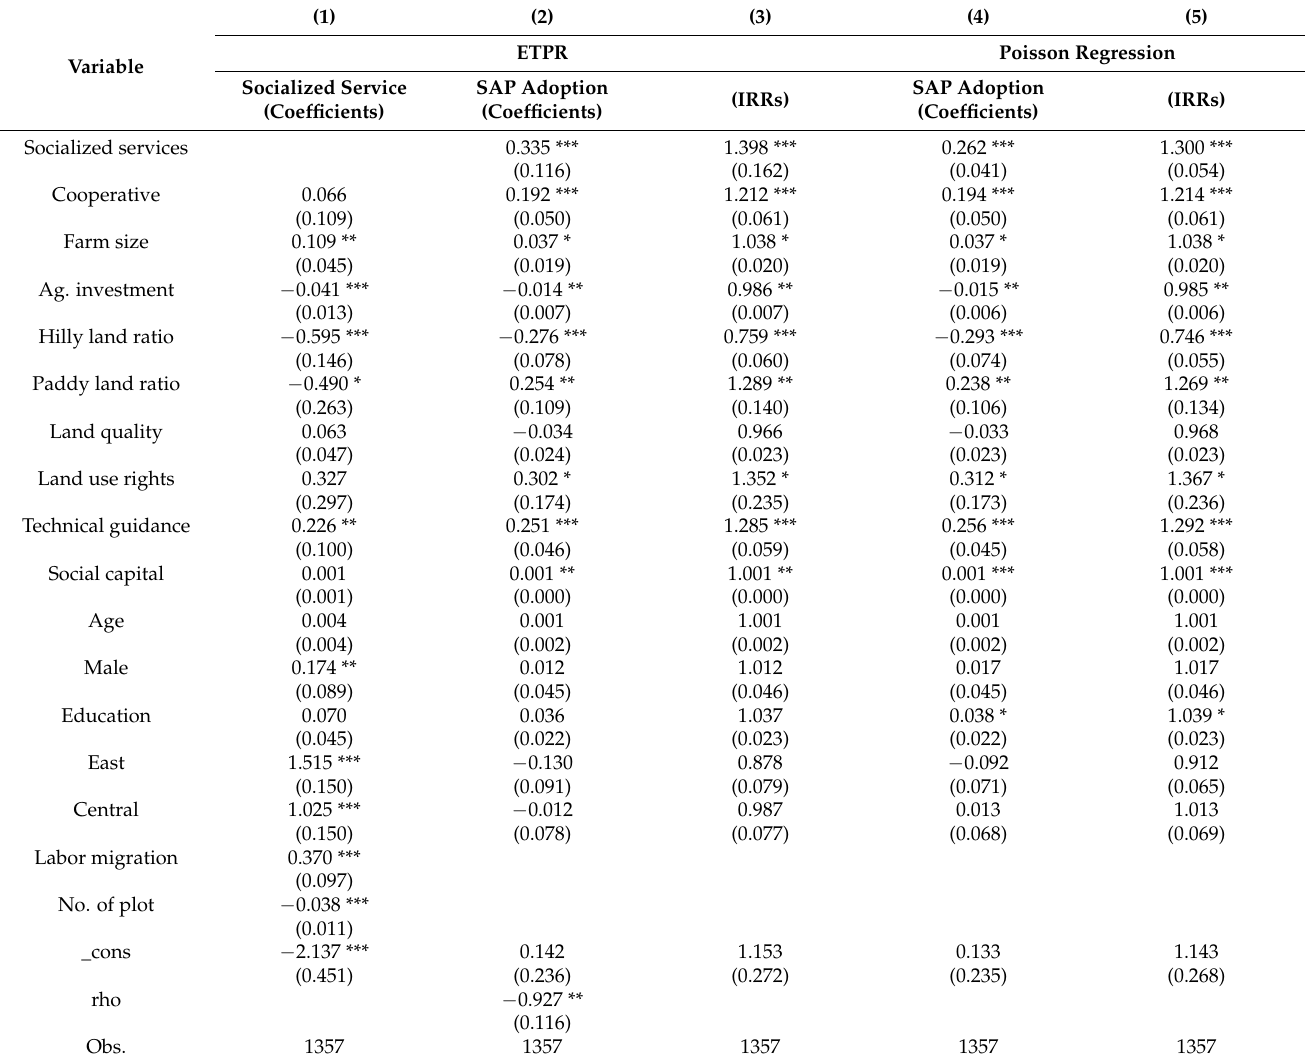
Table 4. Effects of socialized service use on SAP